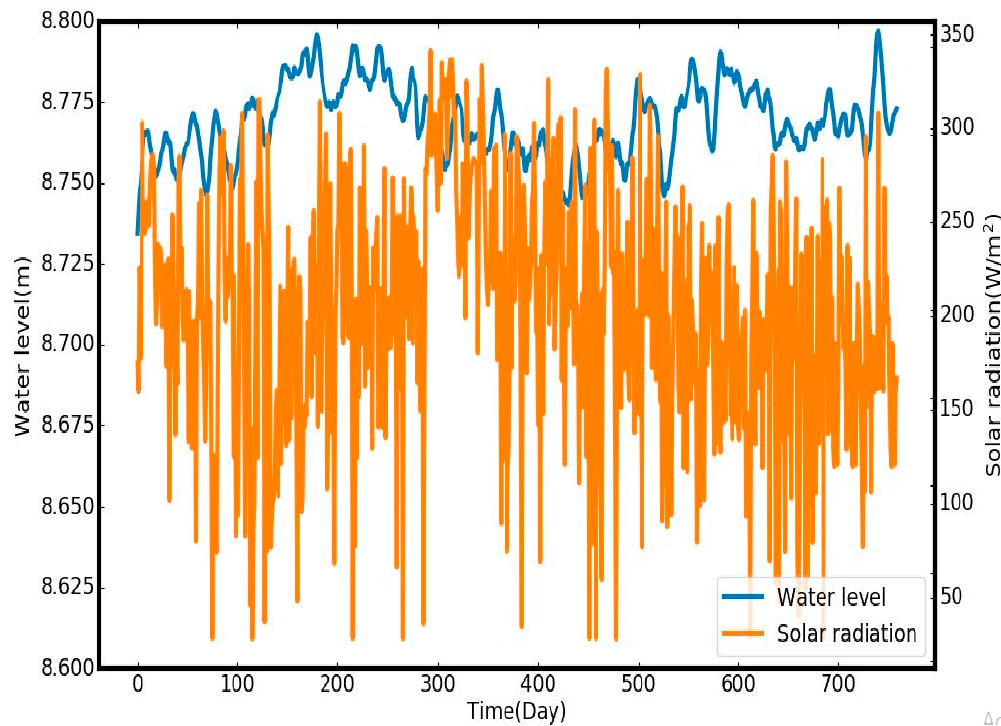
Figure 5. Time series plot of solar radiation and groundwater level collected from the Mukarange monitoring borehole.